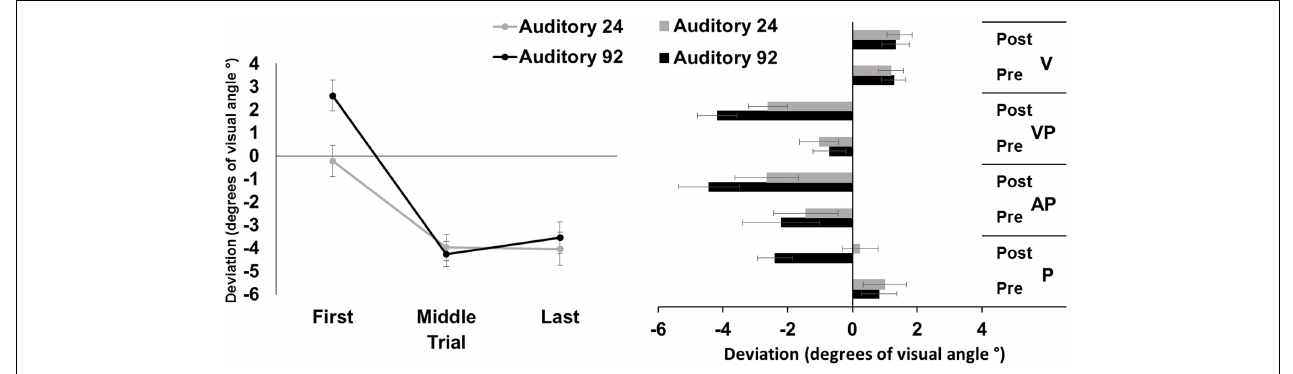
FIGURE 3 | Results from Experiment 3. (Left) Mean (SE) deviation of the pointing movements (average of first, middle, and last four pointings) of the right index finger from the target in the 92-pointings (black) and in the 24-pointings (gray) adaptation conditions to auditory targets, in degrees of visual angle ( ◦ ); positive values correspond to rightward deviations from the auditory targets, negative values to leftward deviations. (Right) Mean (SE) deviation from the body midline in the proprioceptive (P), auditory-proprioceptive (AP), visual-proprioceptive (VP), and visual (V) straight-ahead tests, before (pre), and after (post), the 92-pointings (black), and the 24-pointings (gray) adaptation conditions to auditory targets, in degrees of visual angle ( ◦ ); positive values correspond to rightward deviations from the perceived body midline, negative values to leftward deviations.